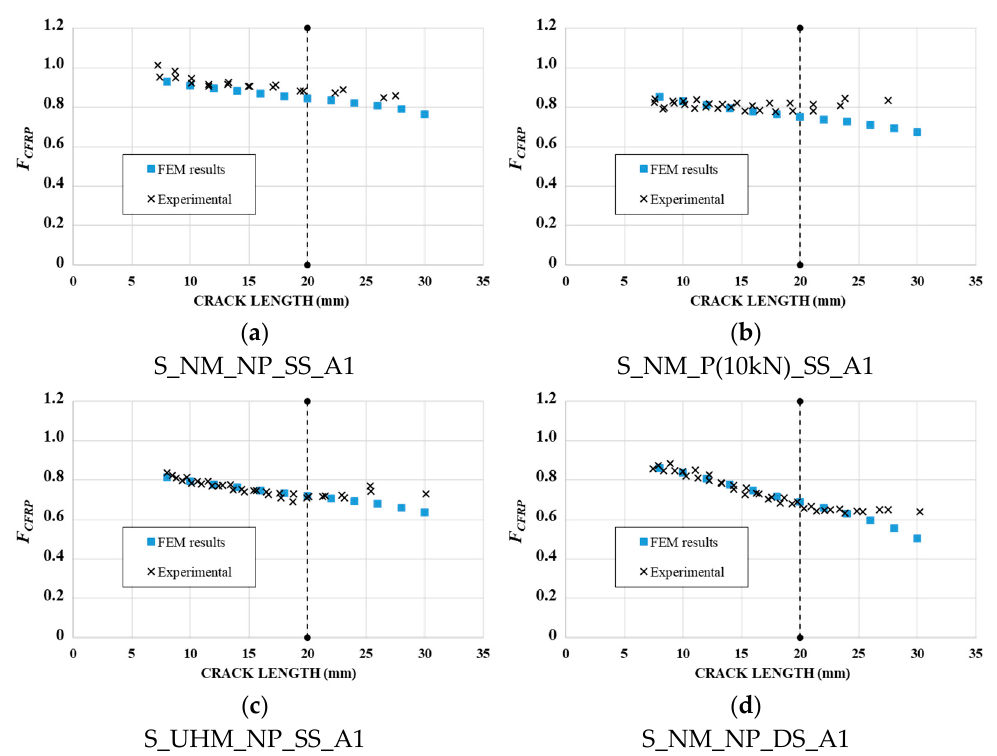
Figure 13. Comparison between experimental and predicted reduction factor, F CFRP , using averaged FEM results: ( a ) NM-non-pre-stressed single-sided reinforced specimen; ( b ) NM-pre-stressed single-sided reinforced specimen; ( c ) UHM-non-pre-stressed single-sided reinforced specimen; ( d ) NM-non-pre-stressed double-sided reinforced specimen.